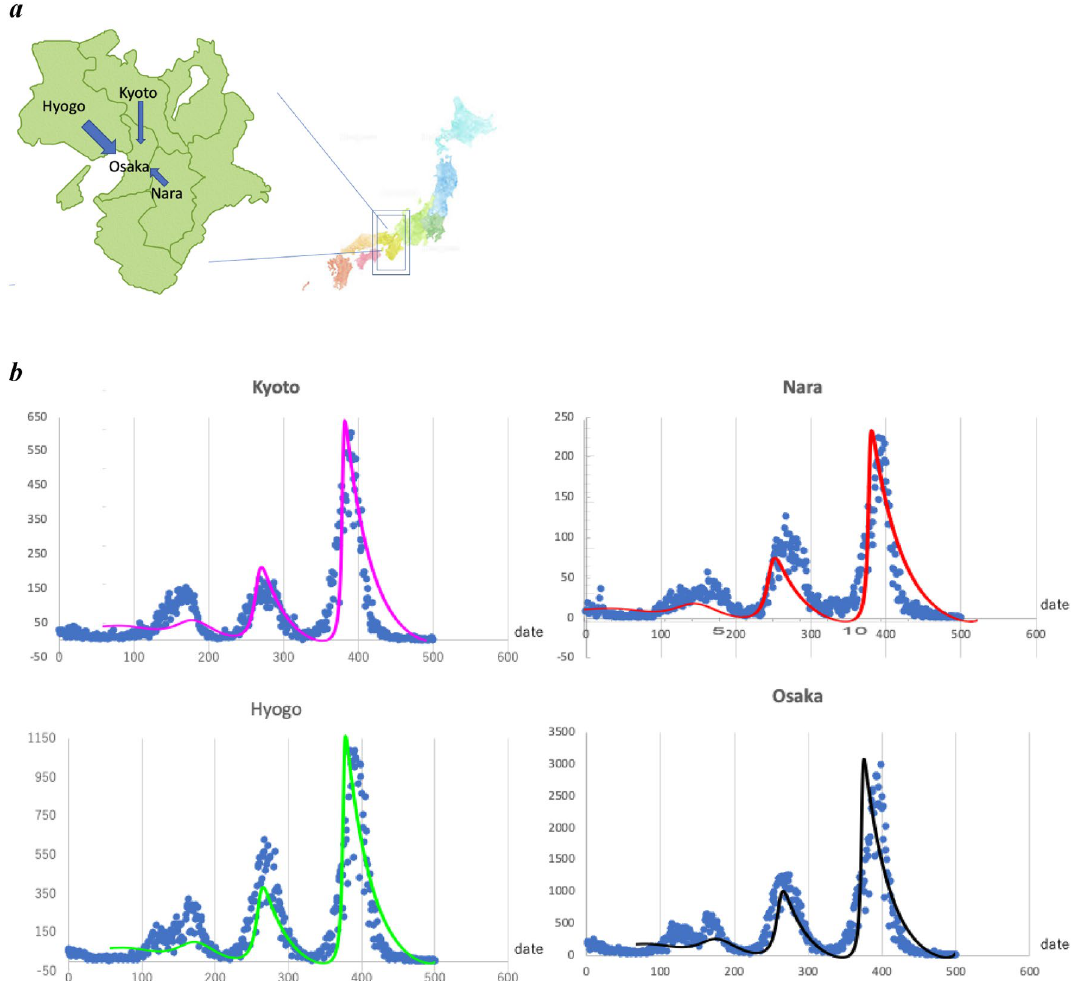
Figure 2. Numerical simulation of the new infection. ( a ) The maps of Japan and the Kansai region are open resources provided freely (https:// frame- illust. com/?p= 10227; https:// image navi. jp/ search/ detail. asp? id= 31596 606). ( b ) Simulation of the newly infected population. The blue circle plot shows the infection number in the Kansai region in Japan (from January 2020 to July 2022). The horizontal axis represents the date from the 200th date of the infection report, and the vertical axis represents the new infection number, respectively. The theoretical plot was fit to the actual maximum and minimal infection number of the plot. W = 1.0 and p = 1.0 for Kyoto (pink), Nara (red), Hyogo(green), and Osaka(black). The simulation calculation was performed using the Mathematica cord (See method, Mathematica was ver 12), shown in the Kansai region. ( c ) The marged four theoretical simulated curves. The horizontal axis represents the date from the 200th date of the infection report. ( d ) The simulated infectious wave oscillation in all of Japan. W = 0.9 and p = 1.0 were used. The line colours are light blue. The blue circle plot shows the new infection number. ( e ) The peak of infected number in each prefecture. The vertical axis represents the new infection number, and the horizontal axis represents the number of the